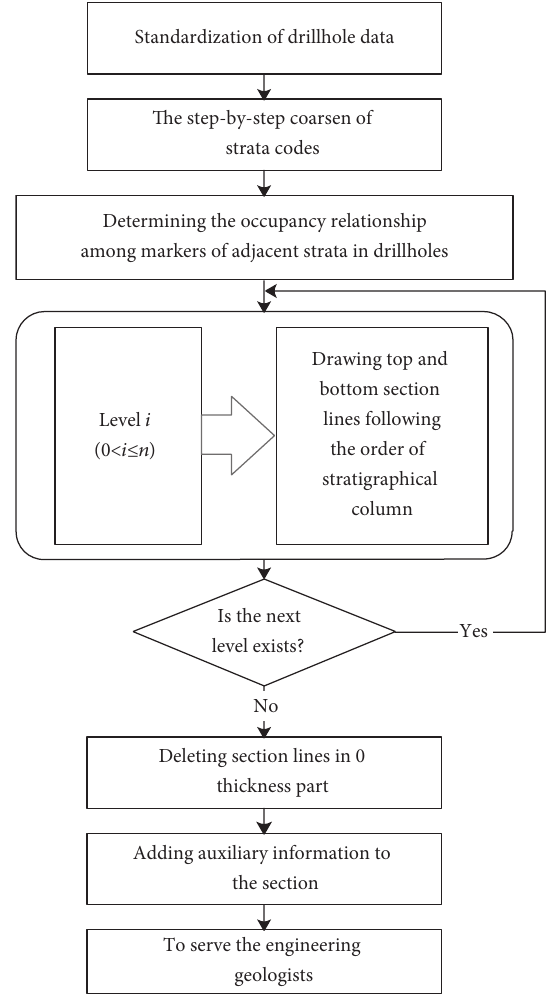
Figure 2: Workflow of automatically drawing multiscale engi- neering